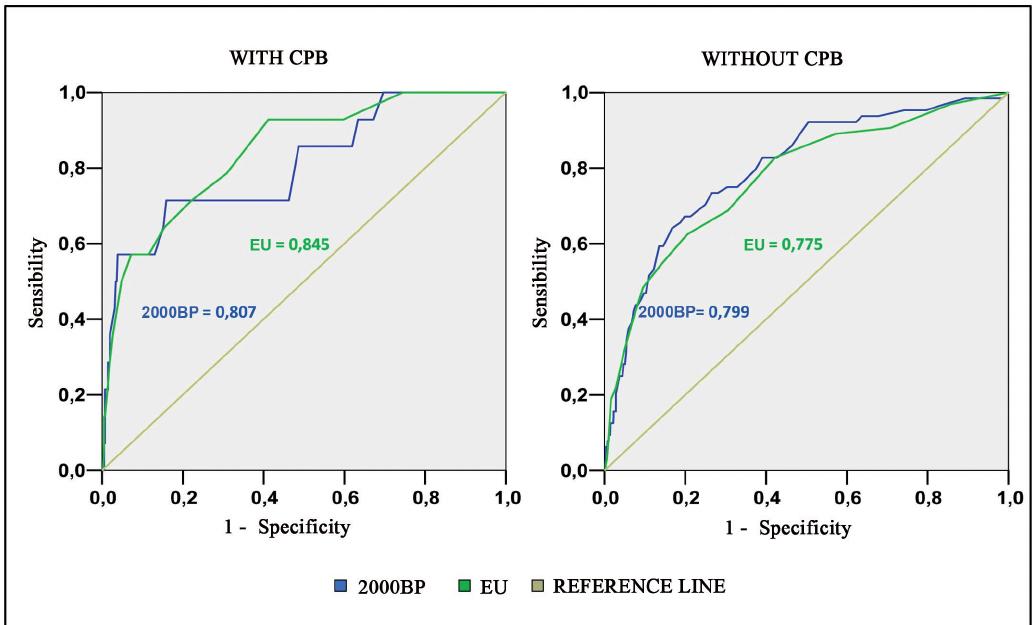
Fig. 2 - ROC curve (Receiver Operating Characteristic) of the 2000 Bernstein Parsonnet (2000BP) and EuroSCORE (EU) for the groups with and without cardiopulmonary bypass for patients undergoing coronary artery bypass